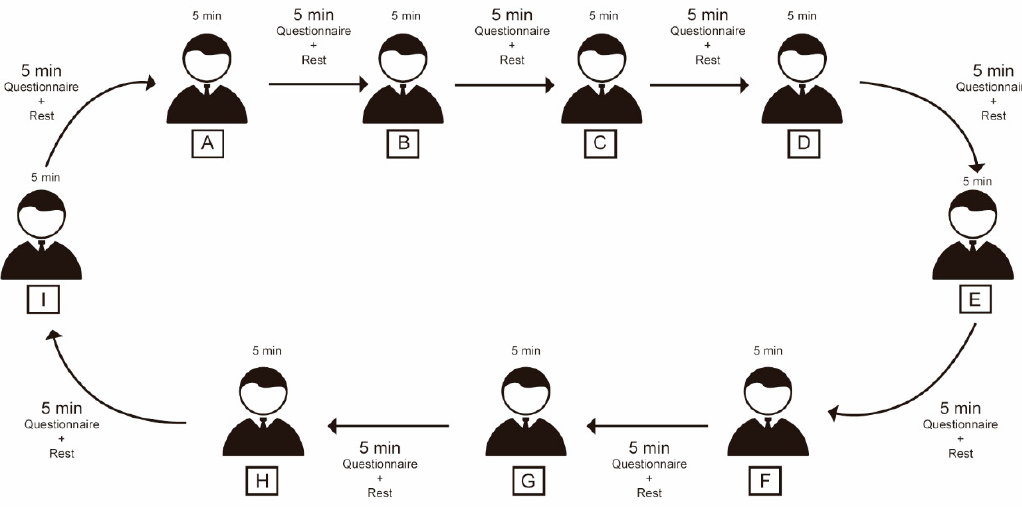
Figure 4. Illustration of the thermal comfort experimental procedure.